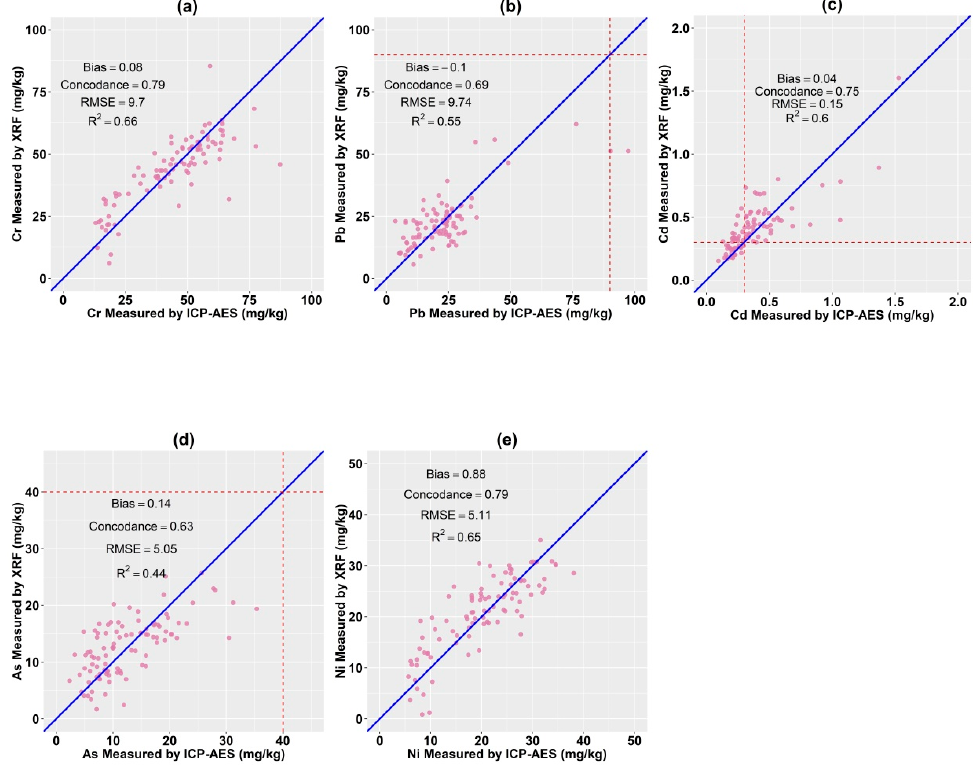
Figure 2. Scatter plot of Cr ( a ), Pb ( b ), Cd ( c ), As ( d ) and Ni ( e ) content measured by laboratory analysis (ICP-AES) and XRF (red dotted line represents the national limit value for corresponding heavy metals).